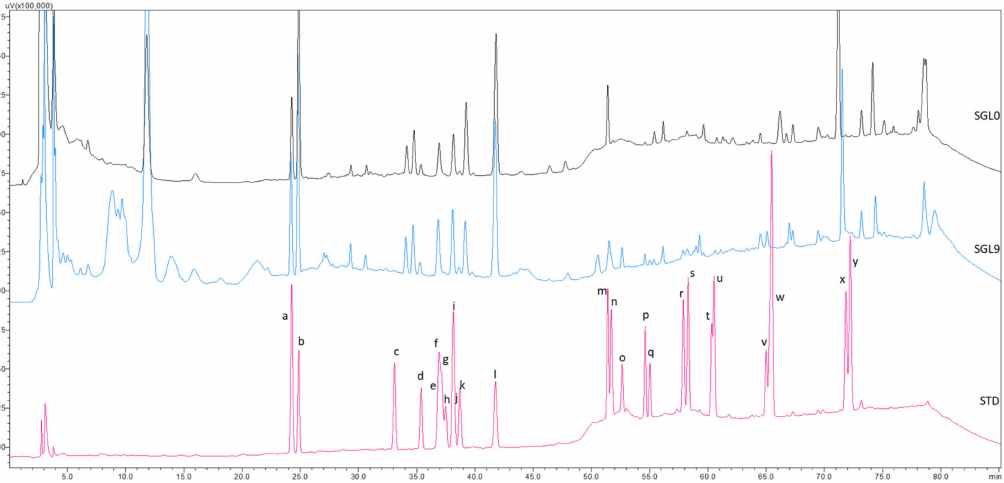
Figure 3. O ff -set HPLC chromatograms of ginsenosides detected from the steamed ginseng leaves (SGL) as compared with the chromatogram of the ginsenoside standards. a, Rg1; b, Re; c, Rf; d, Rb1; e, 20S-Rg2; f, Rc; g, 20S-Rh1; h, 20R-Rg2; i, Rb2; j, 20R-Rh1; k, Rb3; l, Rd; m, F2; n, Rk3; o, Rh4; p, 20S-Rg3; q, 20R-Rg3; r, 20S-PPT; s, 20R-PPT; t, 20S-Rh2; u, 20R-Rh2; v, Rk2; w, Rh3; x, 20S-PPD; y,